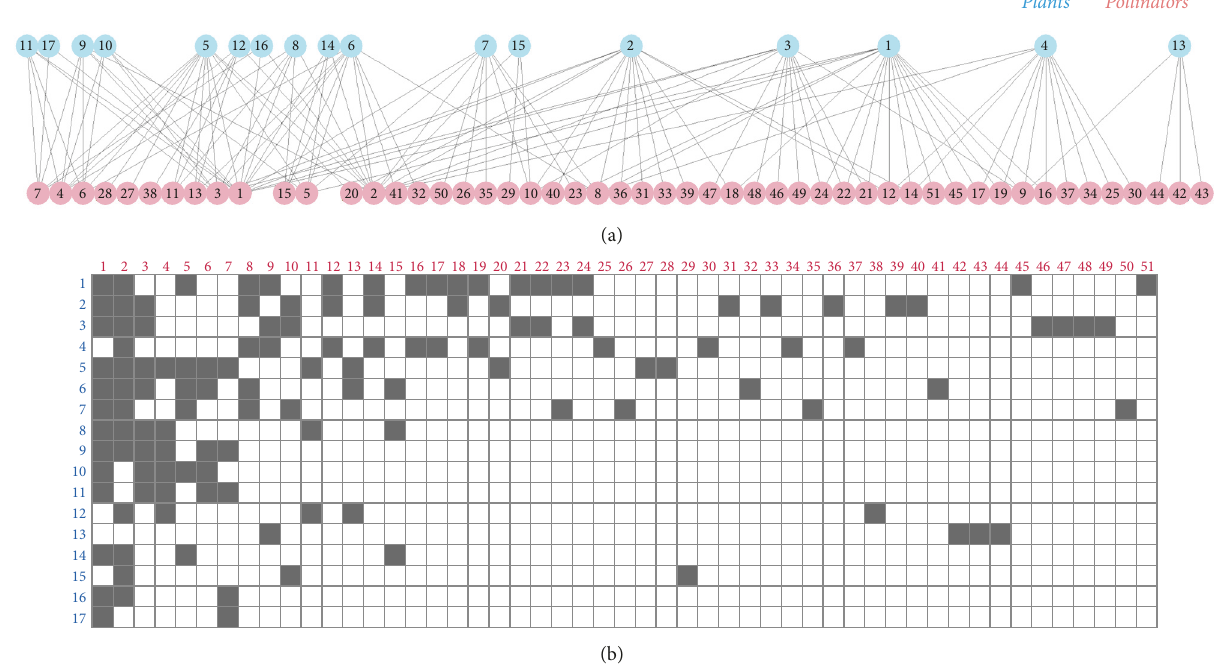
Figure 1: Mutualistic community in Tenerife, Canary Islands (Spain), with 68 species and 129 links [29]. In mutualism, species fall into two disjoint guilds, such as plants and pollinators or plants and seed dispersers. Ties amongst species of the same guild are forbidden. (a) Bipartite plot of this community. (b) Interaction